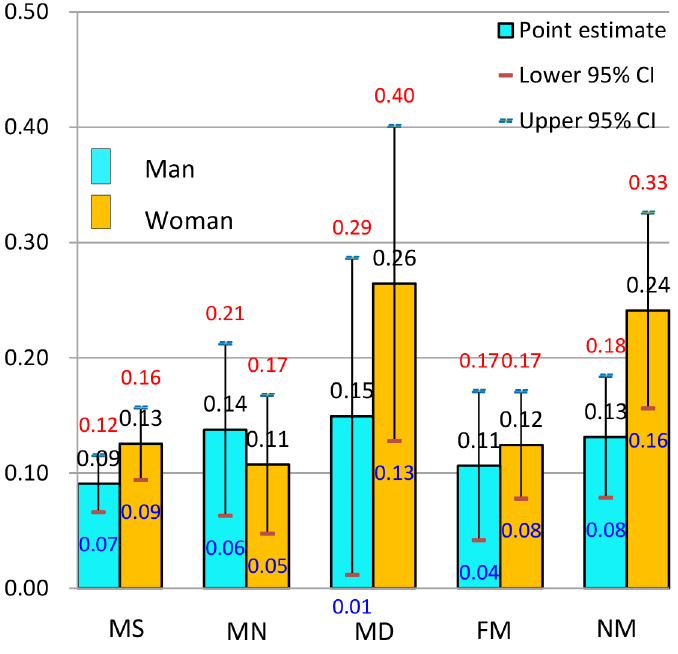
Fig 3. Predicted probability (and 95% confidence intervals) of reporting poor health by gender in Taiwan, the 2006 East Asian Social Survey.